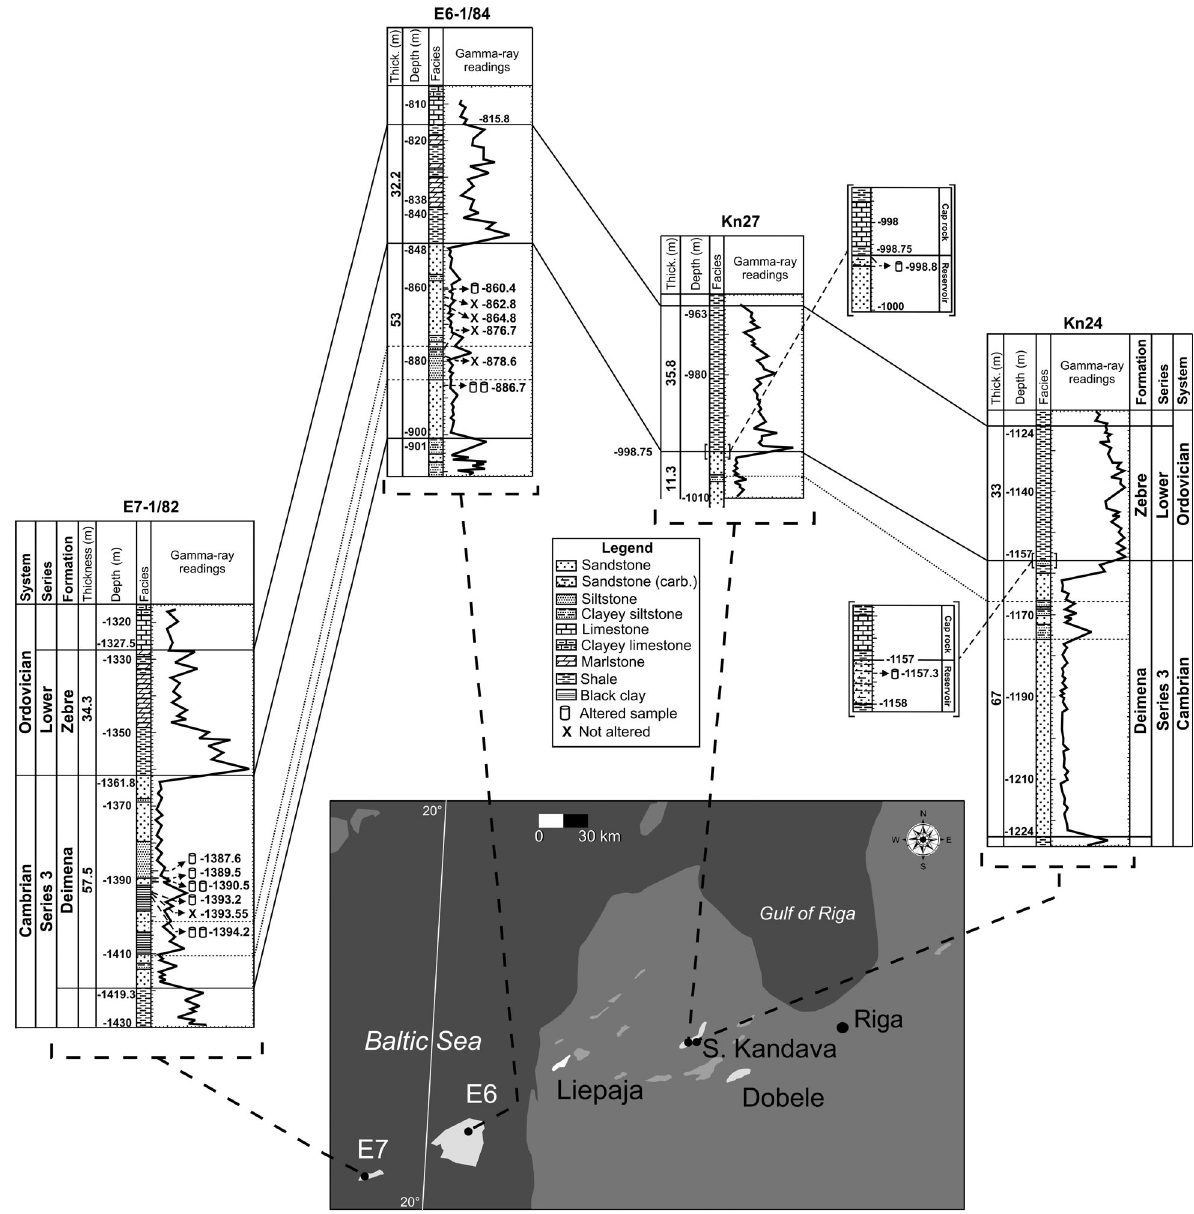
Fig. 1. Correlation of boreholes from the studied offshore E6 and E7 structures (E6-1/84 and E7-1/82) and onshore South Kandava (S. Kandava, Kn24, Kn27) focusing on the sandstone reservoir of the Deimena Formation of Cambrian Series 3. Cap rocks are represented by the Lower Ordovician Zebre Formation (primary cap rock) and part of the secondary cap rock (Middle Ordovician Kriukai Formation). Gamma-ray readings were digitized from analogous gamma-ray logging data. Approximate locations of the studied structures (white) and boreholes (black points) are indicated on the map. Other onshore Latvian structures prospective for CGS (CO 2 storage potential exceeding 2 Mt) are shown in light